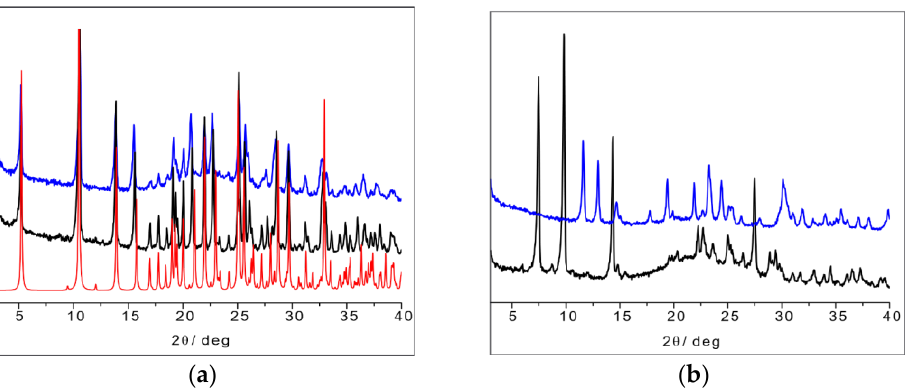
Figure 16. ( a ) L-His 2 ·Ag (TIGHEY) [56] calculated pattern from database (in red), experimental XRPD pattern from slurry synthetic procedure of L-His 2 ·Ag (in black), and DL-His 2 ·Ag (in blue); ( b ) experimental XRPD pattern from slurry of L-His·Ag (in black) and DL-His·Ag (in blue).